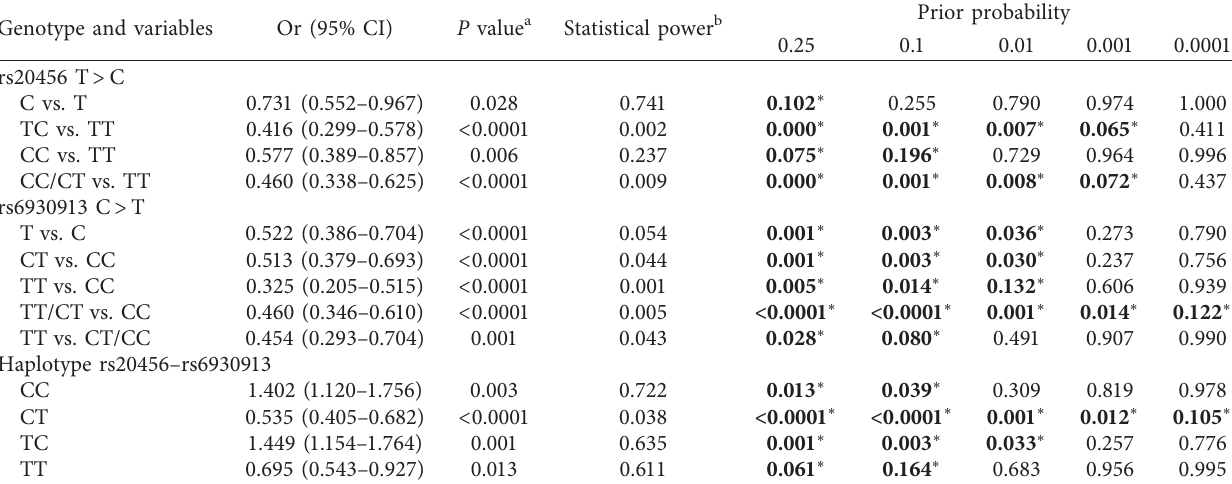
Table 6: Results of false-positive report probability analysis for the risk associations of rs20456 and rs6930913 polymorphisms to hypertension.